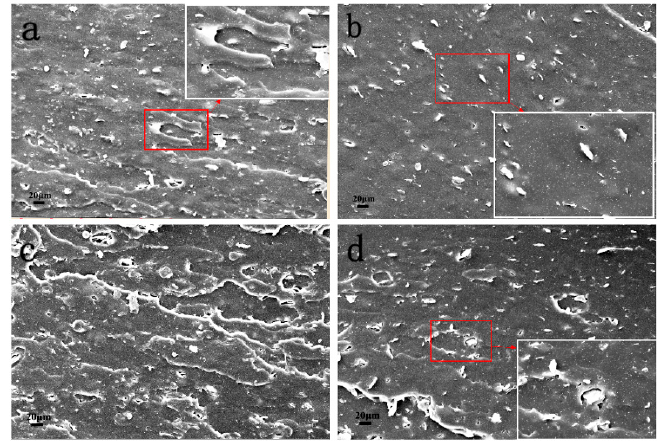
Figure 9. Elongation at break of NBR composites at different aging times.